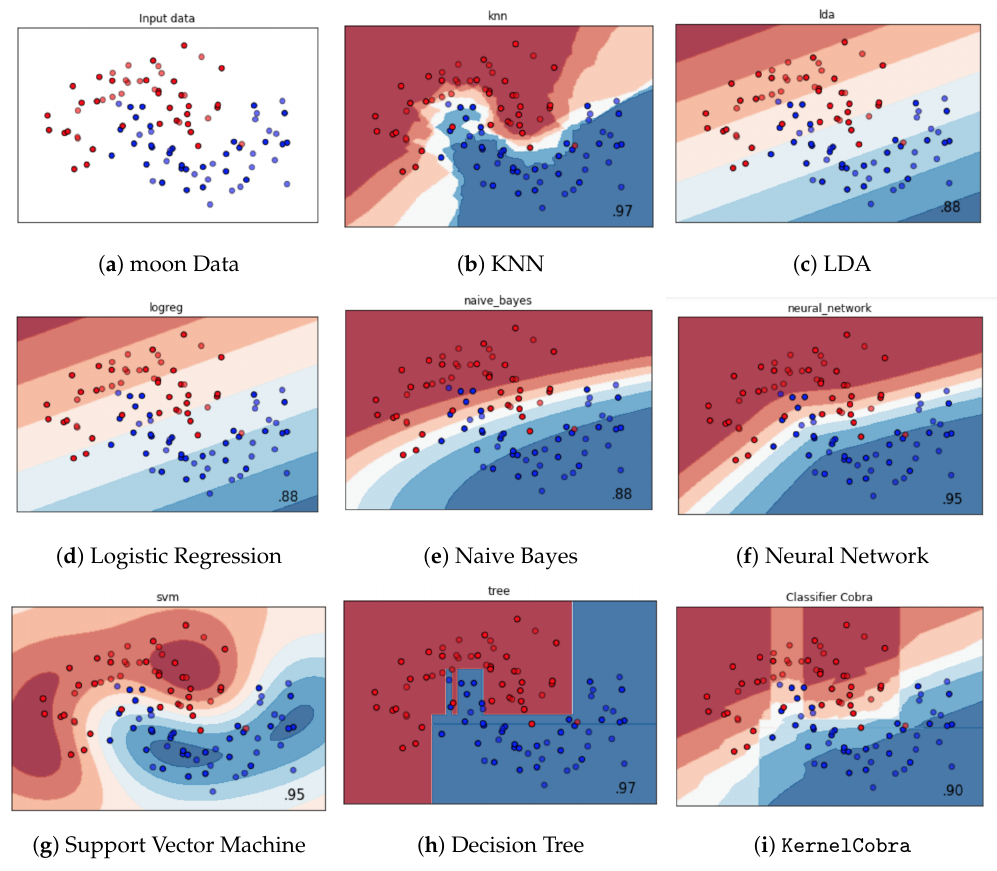
Figure 4. Decision boundaries of base classifiers and KernelCobra on the moon